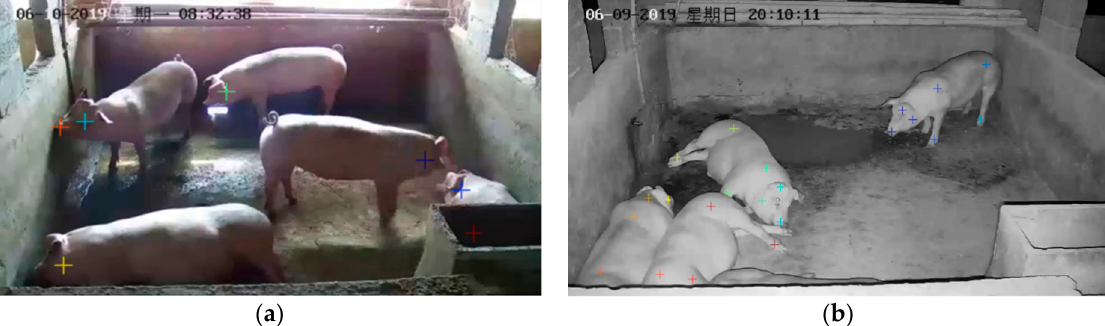
Figure 6. Sampling point modification. ( a ) The modified sample during the day; ( b ) the modified sample at night.